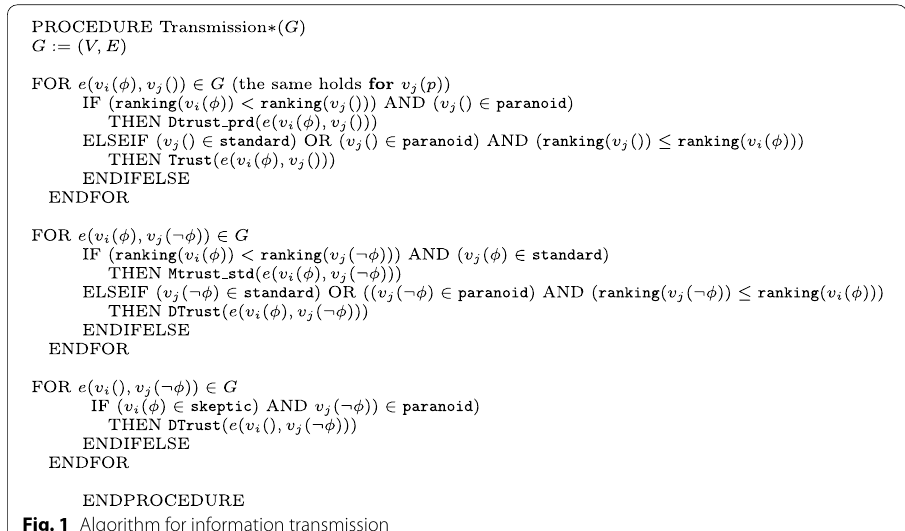
Fig. 1 Algorithm for information